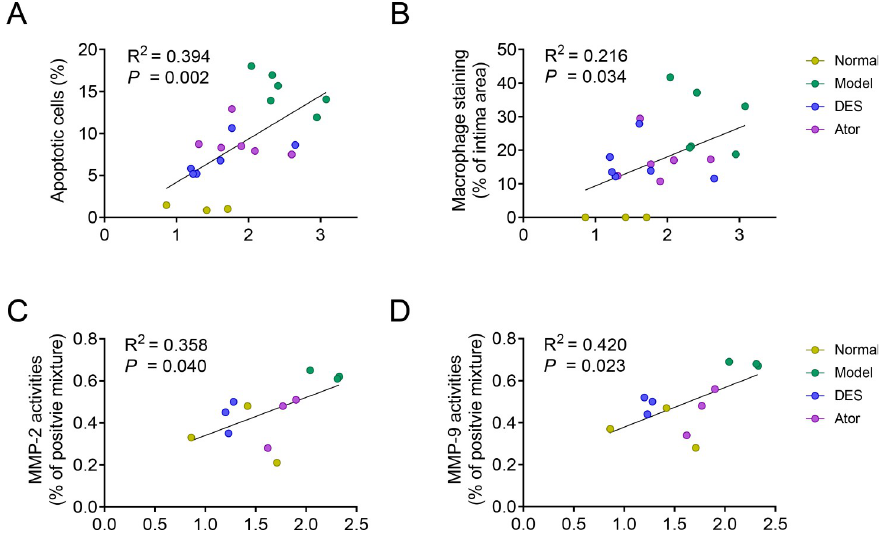
Fig 4. Correlations of quantitative radioactive uptake of 99m Tc-duramycin and plaques instability. (A) Correlations of quantitative radioactive uptake of 99m Tc-duramycin with apoptotic cells stained with TUNEL, (B) area stained by RAM-11 (expressed as macrophage percentage of total plaque area or total cell numbers), (C, D) and MMPs activities. n = 12 to 21.